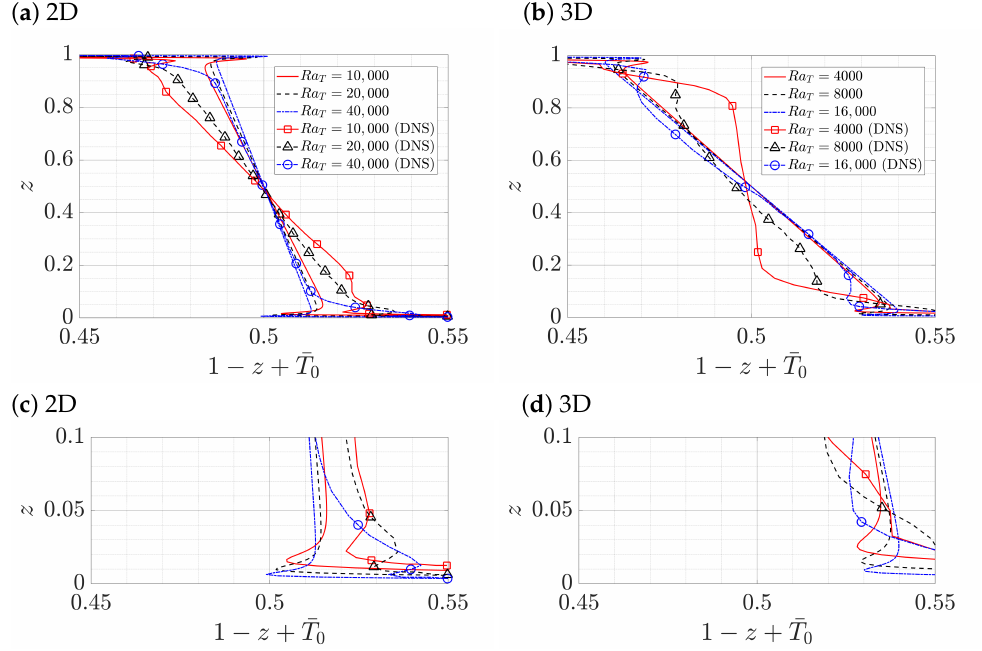
Figure 2. Comparisons of the mean temperature profiles obtained from single-mode solutions (lines) with DNS (lines with markers). Panel ( a ) displays 2D results at Ra T = 10,000, 20,000 and 40,000 using k x = 0.48 Ra 0.4 and k y = 0 compared with 2D DNS (Figure 3a in [25]). Panel ( b ) shows 3D results at T Ra T = 4000, 8000 and 16,000 using k x = k y = 0.17 Ra 0.52 compared with 3D DNS (Figure 7 in [27]). T Panels ( c ) and ( d ) show zooms of panels ( a ) and ( b ) near the bottom boundary,